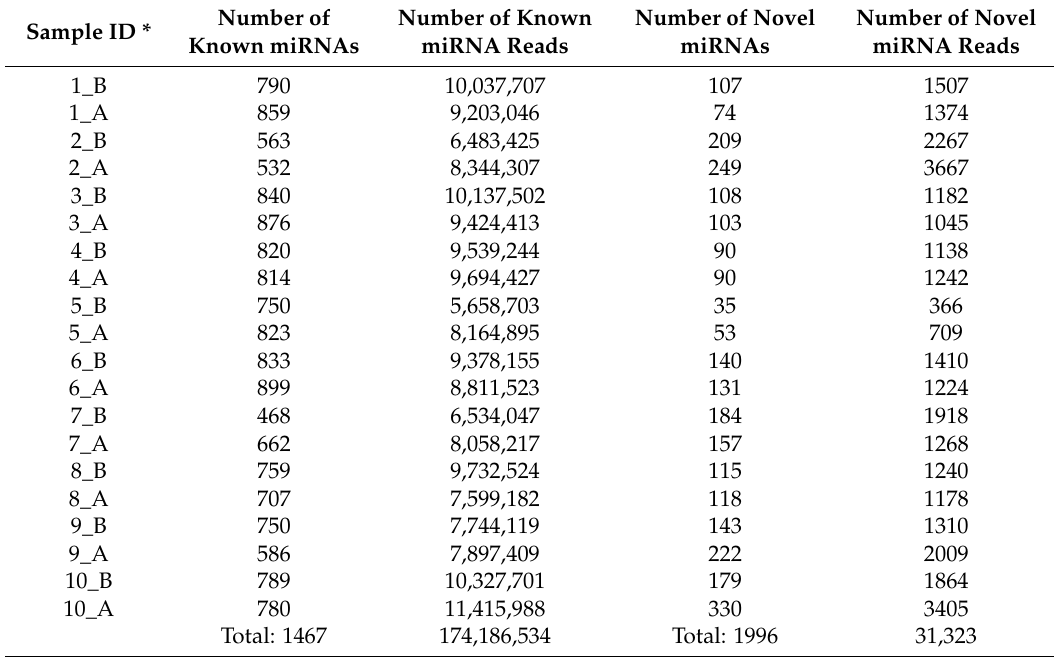
Table 1. A list of all known and novel miRNA species number in each sample with the total number of reads that were generated from small RNA sequencing using Solexa.